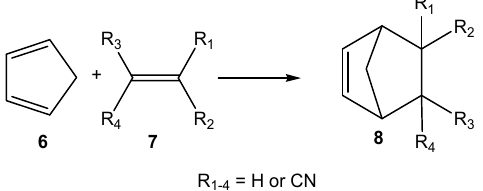
Scheme 2. DA reactions between Cp 6 and the cyanoethylene series 7 giving the series of cyclohexene derivatives 8 .